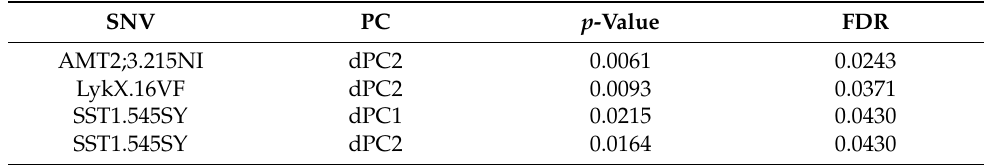
Table 9. Selected associations with PC